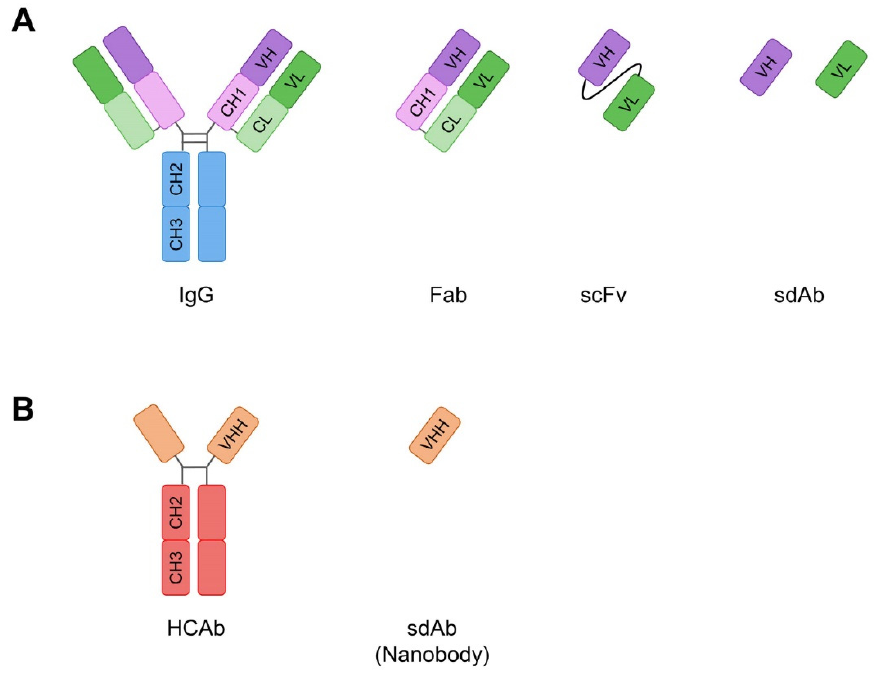
Figure 1. Different antibody formats. ( A ) Full-length immunoglobulin G (IgG) and its derivatives Fab (fragment antigen-binding), scFv (single chain fragment variable) and sdAb (single domain antibody). VH (variable heavy) and VL (variable light) are the domains that enable the binding to the antigen. ( B ) Heavy chain only antibody (HCAb) found in Camelidae and its derivative VHH (variable heavy domain of heavy chain only antibody) that is a sdAb and is also called